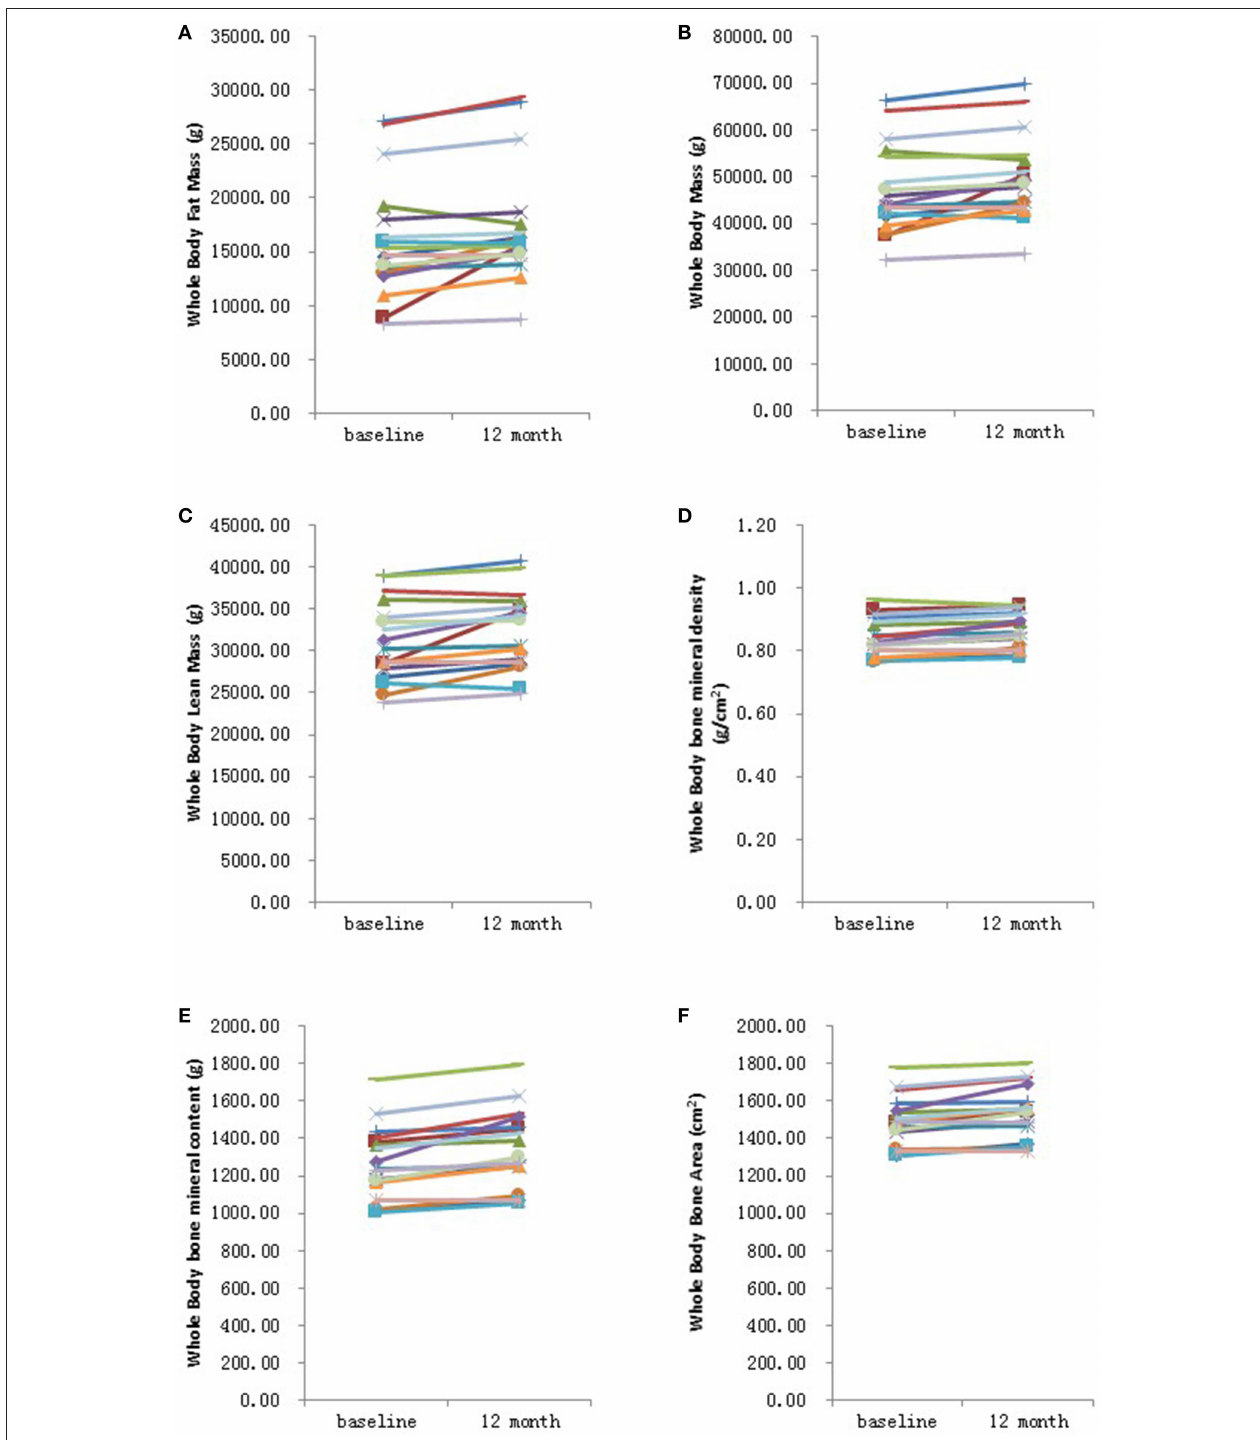
FIGURE 1 | Graphical representation in changes in whole body measurements before and after 12 months HRT. (A) Whole body fat mass; (B) Whole body mass; (C) Whole body lean mass; (D) Whole body bone mineral density; (E) Whole body bone mineral content; (F) Whole bone area. N = 17. 2 diabetes, and cardiovascular disease for TS patients. Therefore, strength and can prevent bone fractures (4). In addition, keeping the positive effect of HRT on body composition in TS women a fit body shape and low fat mass can also help prevent other may also lead to lifelong health serious chronic metabolic health problems such as obesity, type